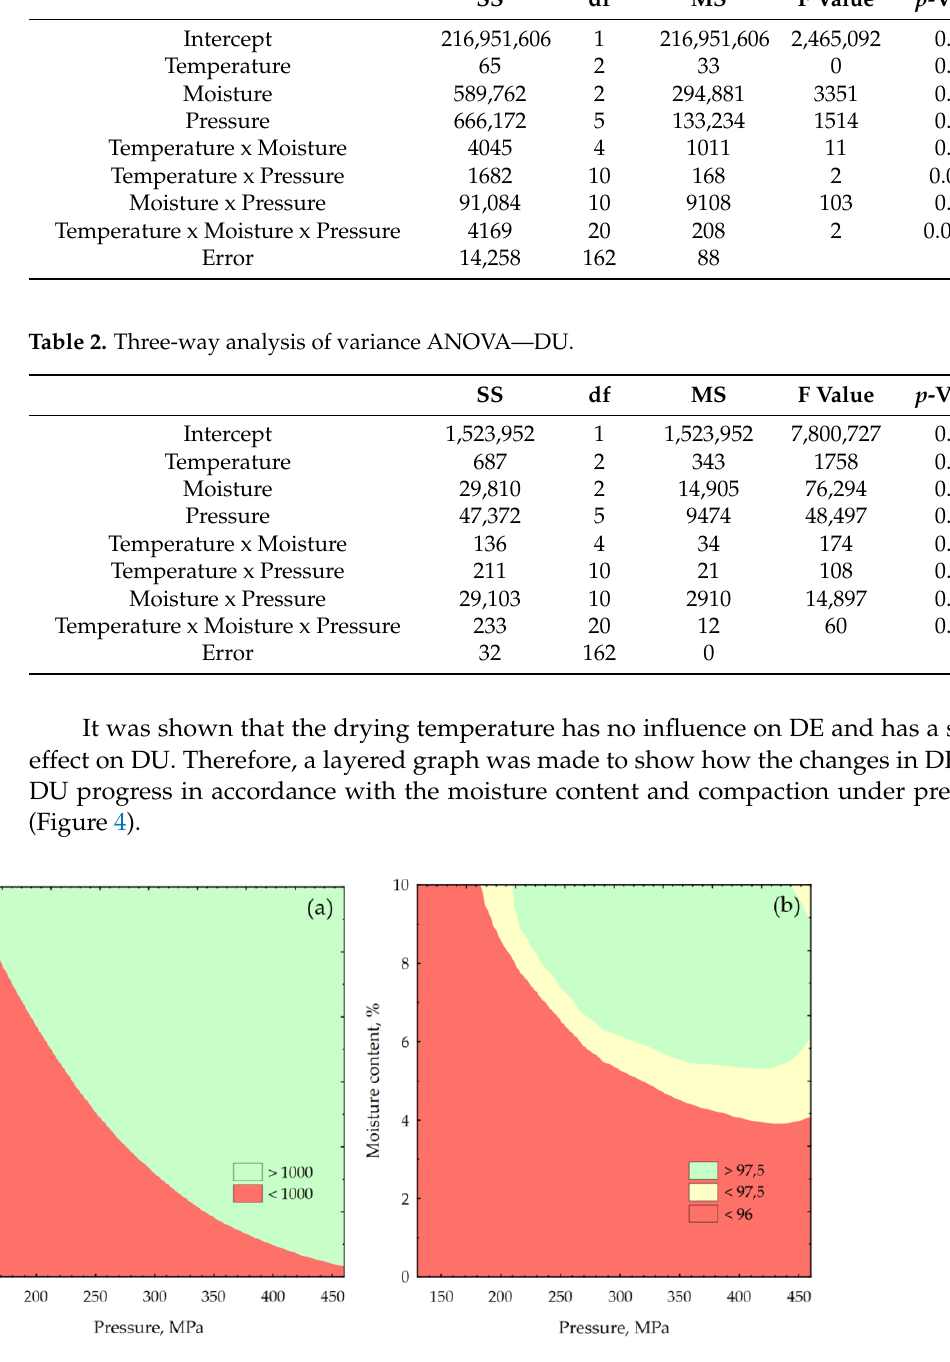
Figure 4. Changes of test pellet quality due to moisture content and compaction pressure: ( a ) specific density and ( b ) mechanical durability.